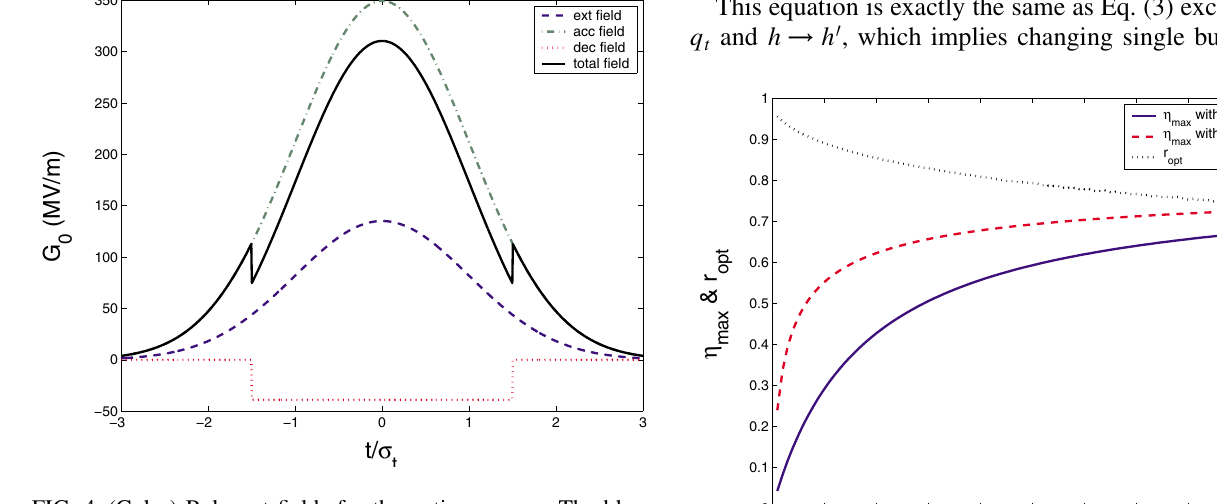
FIG. 4. (Color) Relevant fields for the optimum case. The blue dashed curve is the external laser field and the black solid curve is the unloaded gradient, which is the sum of acceleration gradient due to laser field and deceleration gradient due to wakefield. The time scale is normalized by the duration of the external laser pulse.